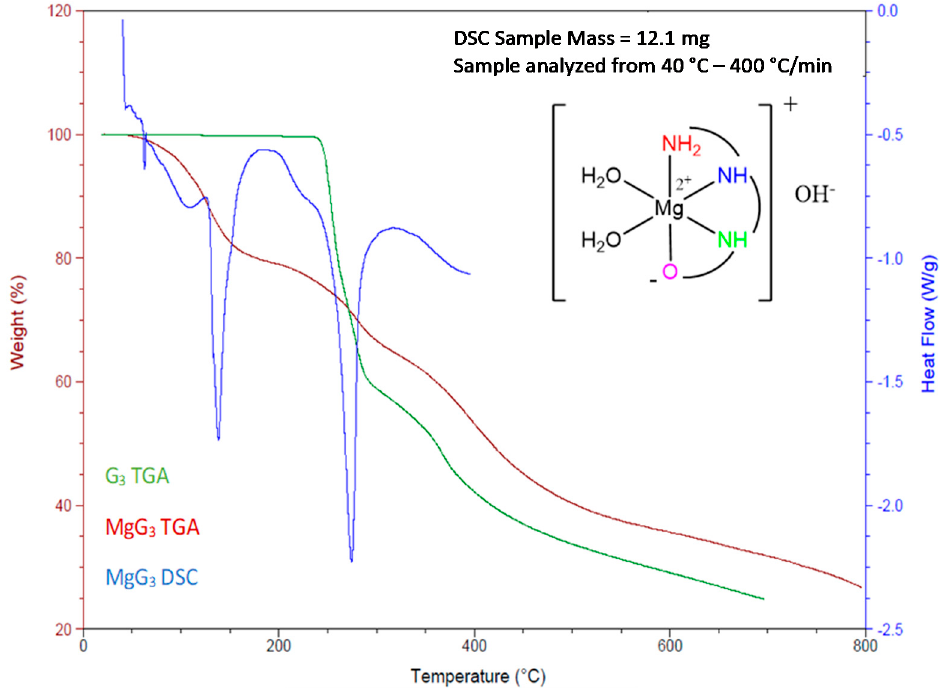
Figure 6. Solid state characterization of MgG 3 showing the TGA of HG 3 ( green ) showing only one continuous weight percent change beginning at 240 ◦ C, the TGA of MgG 3 ( maroon ) showing multiple weight percent changes, further highlighted by the three observable endotherms of the DSC of MgG 3 ( blue ).